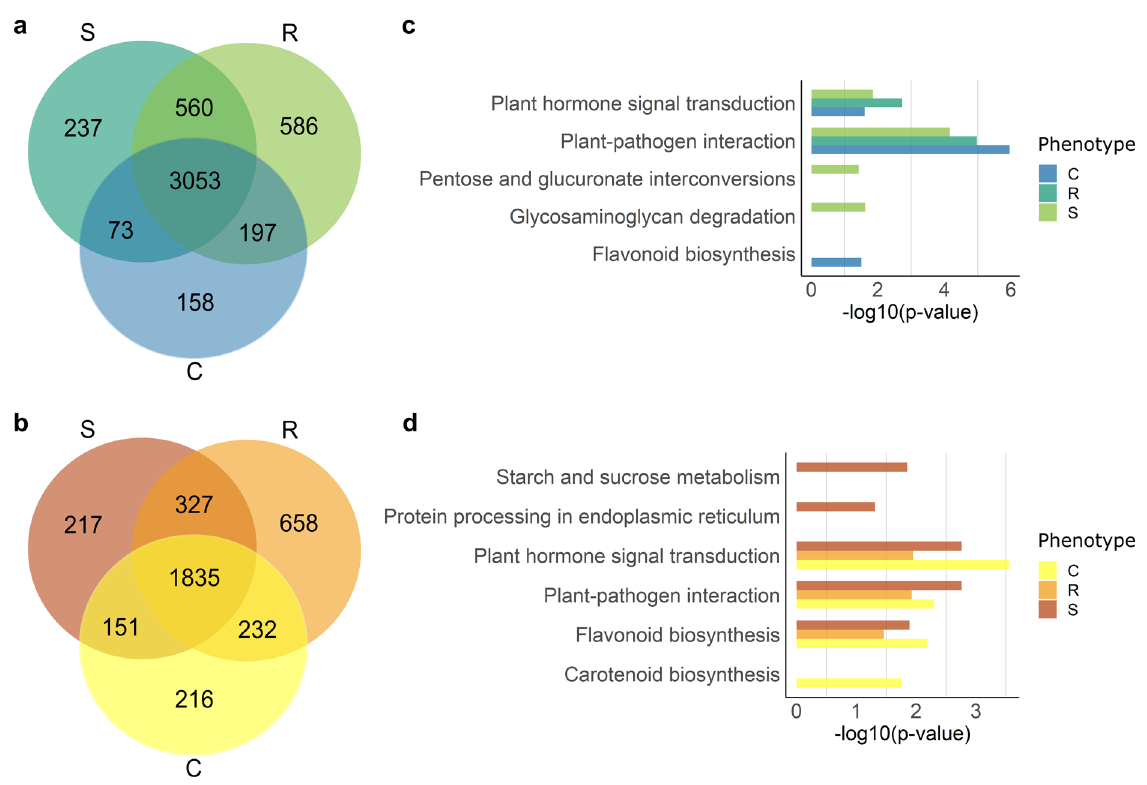
Figure 1. Number of expressed Pinus pinaster miRNAs ( a ) and tasiRNAs ( b ) in susceptible (S), resistant (R), and control (C) samples. Pathway enrichment analysis 26,27 of predicted target genes of the expressed miRNAs ( c ) and tasiRNAs ( d ). The x-axis represents the significance of pathway enrichment (− log10 of corrected p -values) ( c,d ). Venn diagrams were generated online (https:// bioin forma tics. psb. ugent. be/ webto ols/ Venn/) and edited with Inkscape 1.1 (https:// inksc ape. org/). Bar plots were generated with R 4.1.0 (https:// cran.r- proje ct. org/) ggplot2 package (https:// ggplo t2. tidyv erse. org/). Pinus pinaster Bursaphelencus xylophilus Total Susceptible